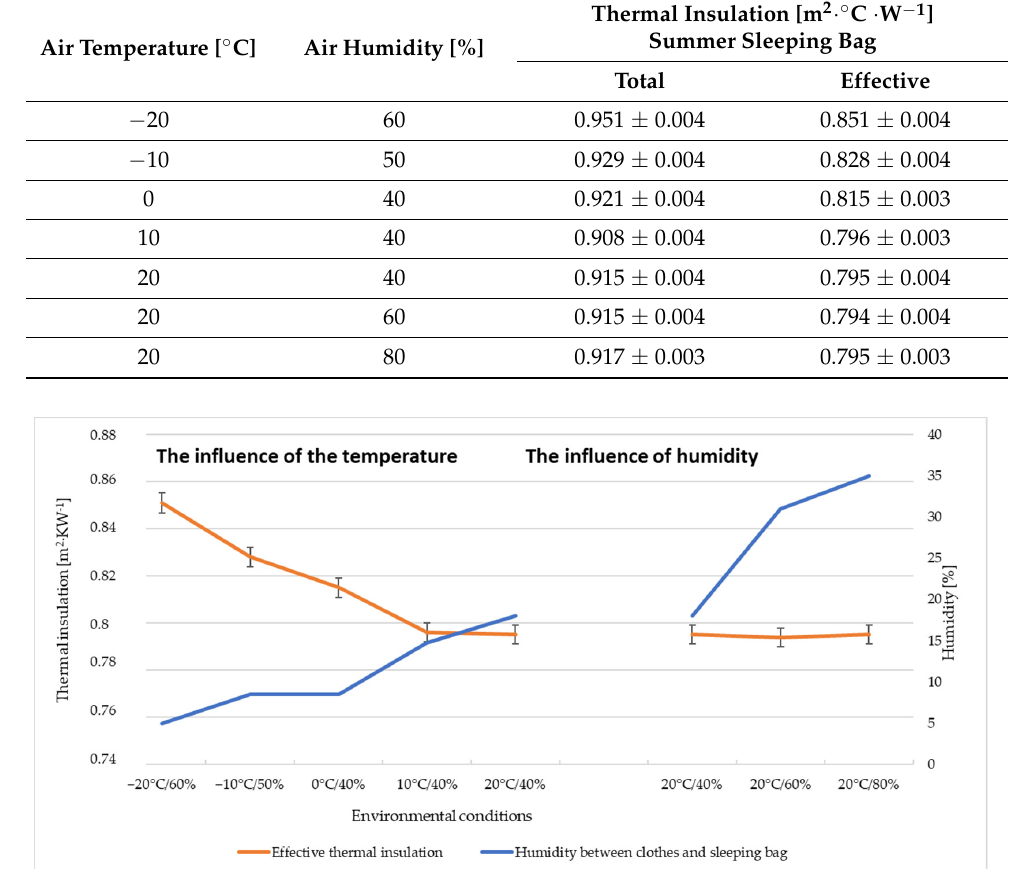
Figure 9. Thermal insulation of a mannequin in a summer sleeping bag. Table 6. Average thermal insulation of a mannequin in a summer sleeping bag .